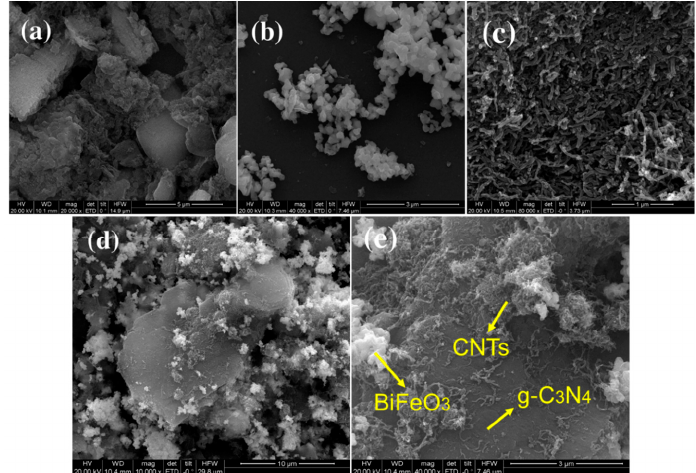
Figure 1. SEM images of ( a ) graphite-phase carbon nitride (g-C 3 N 4 ), ( b ) bismuth ferrite (BiFeO 3 ), ( c ) carbon nanotubes (CNTs), ( d ) g-C 3 N 4 /BiFeO 3 (CNB), and ( e ) carbon nanotubes ternary magnetic composite (CNBT).